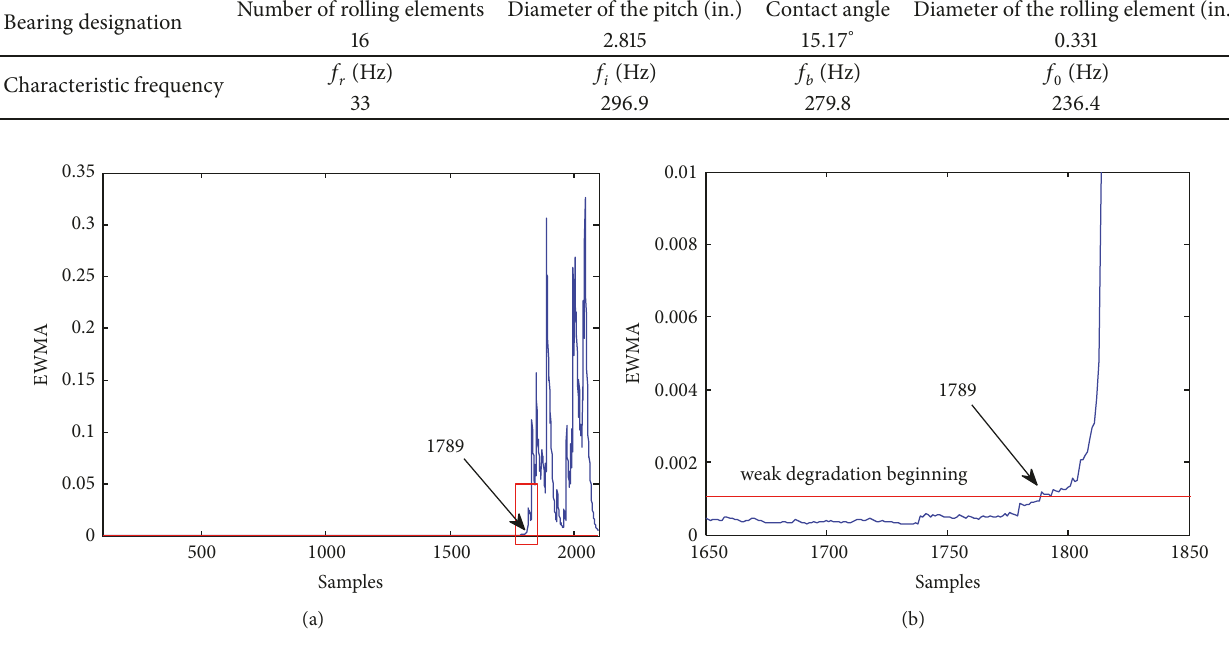
Figure 8: Monitoring charts by NLOPE: (a) EWMA statistic; (b) local enlargement of (a).